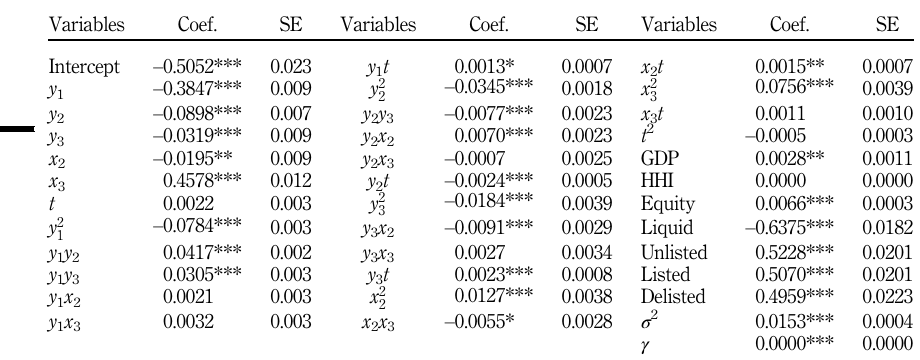
Table AI. DDF regression for